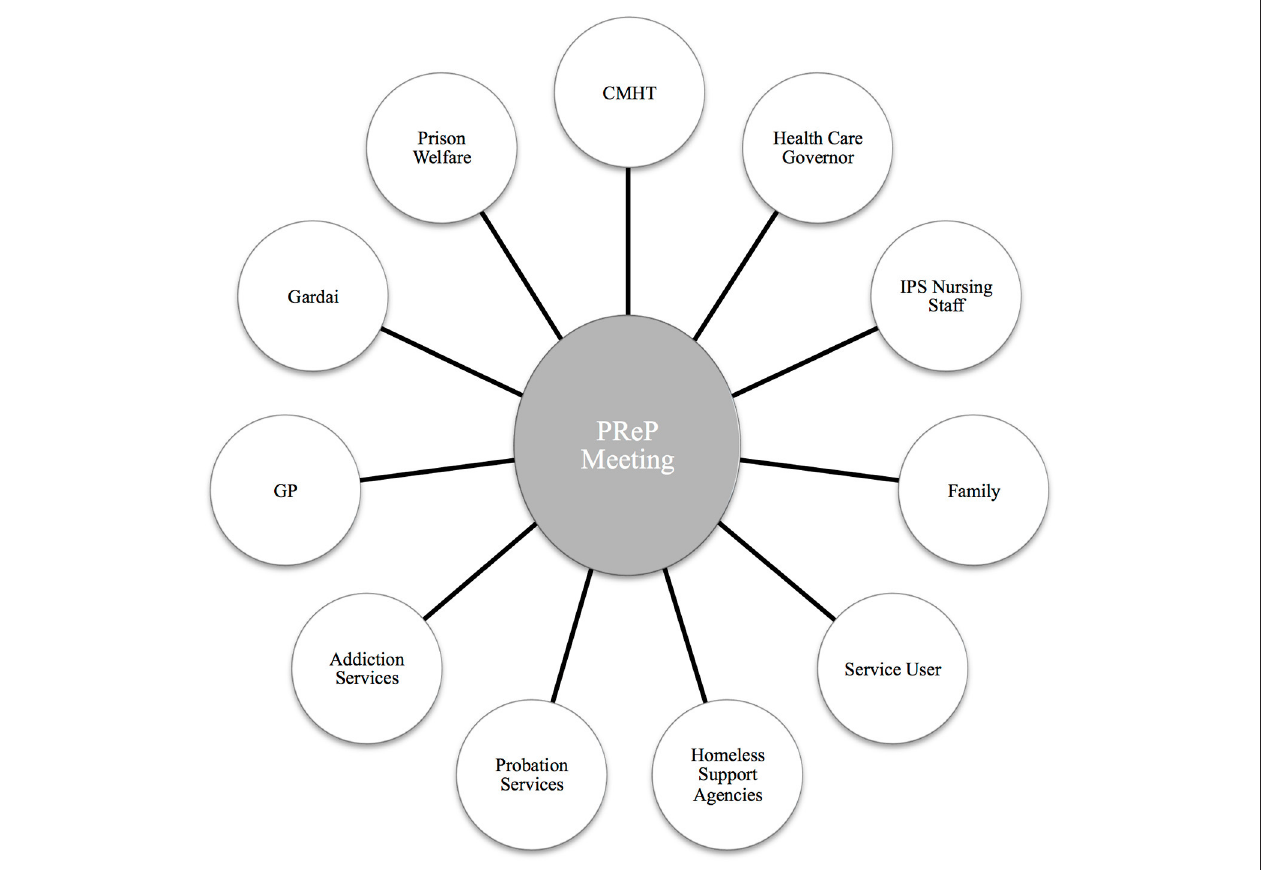
FIGURE 1 | Examples of stakeholders invited to attend Pre-Release Planning (PReP) meetings prior to the individual’s release. CMHT, Community Mental health Team; IPS, Irish Prison Service; GP, General